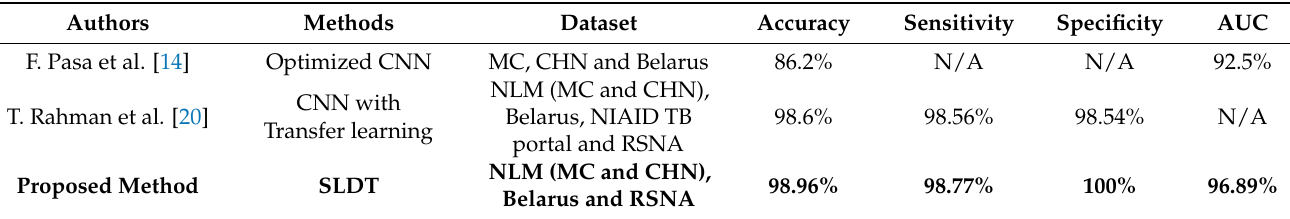
Table 4. Performance measures of the proposed method with existing methods by combined dataset 2 (NLM, Belarus and